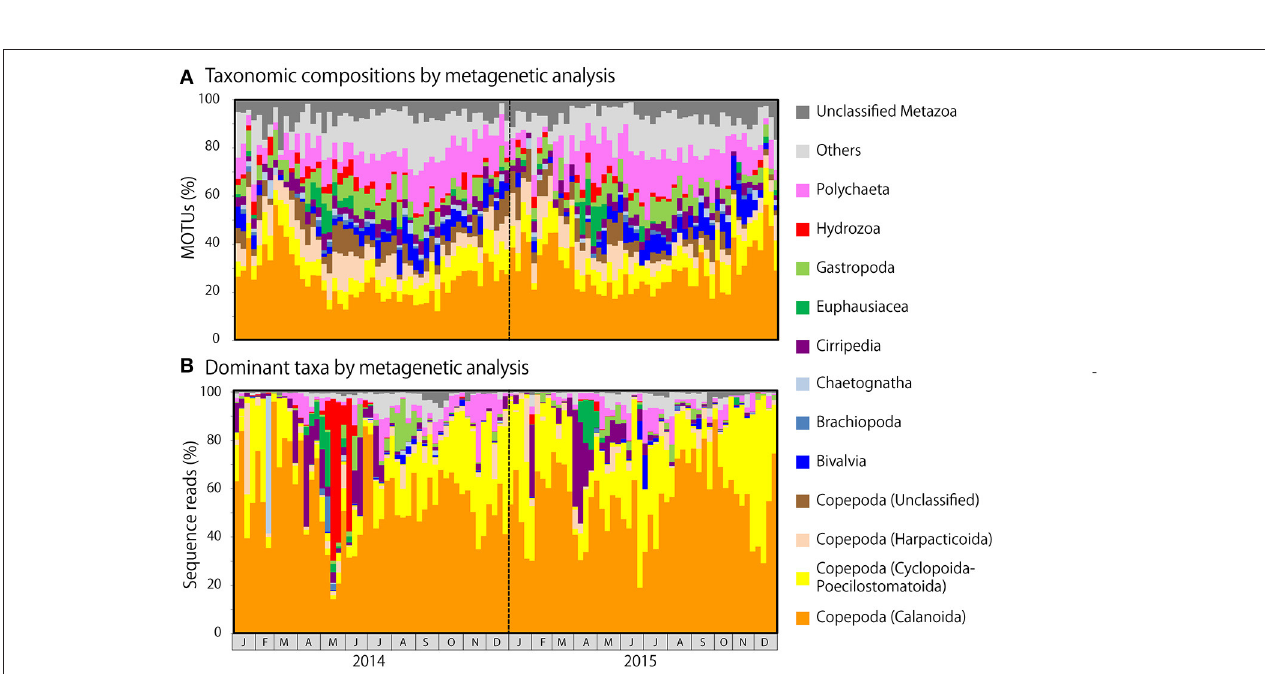
FIGURE 5 | Metagenetic detection of seasonal changes in (A) taxonomic compositions, as measured by the proportion of molecular taxonomic units (MOTUs) per sample attributable to major taxonomic groups, and (B) the identity of dominant taxa, as measured by the proportion of sequence reads per sample attributable to major taxonomic groups. MOTUs and sequence reads attributable to Copepoda are classified to order. Taxonomic groups that did not contribute to ≥ 10% of all sequences in any sample are grouped under others.